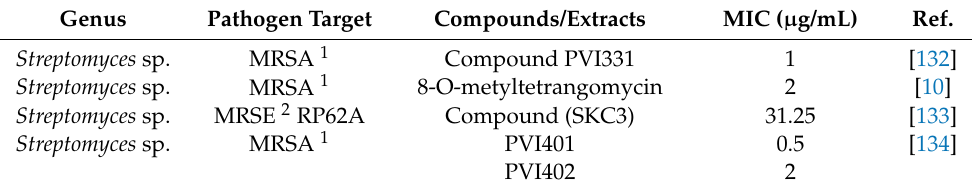
Table 3. Antibacterial and anti-biofilm activity of actinobacterial crude extracts or compounds from Streptomyces